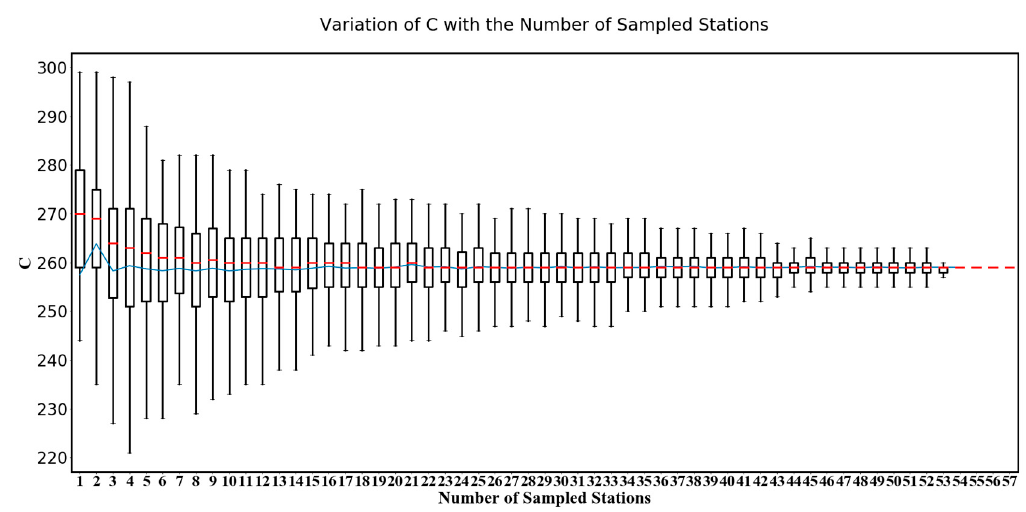
Figure 6. Boxplot which represents variation of C with the number of sampled stations, the red line represents the median of data within the box body and the blue line represents the mean of data within the box body.